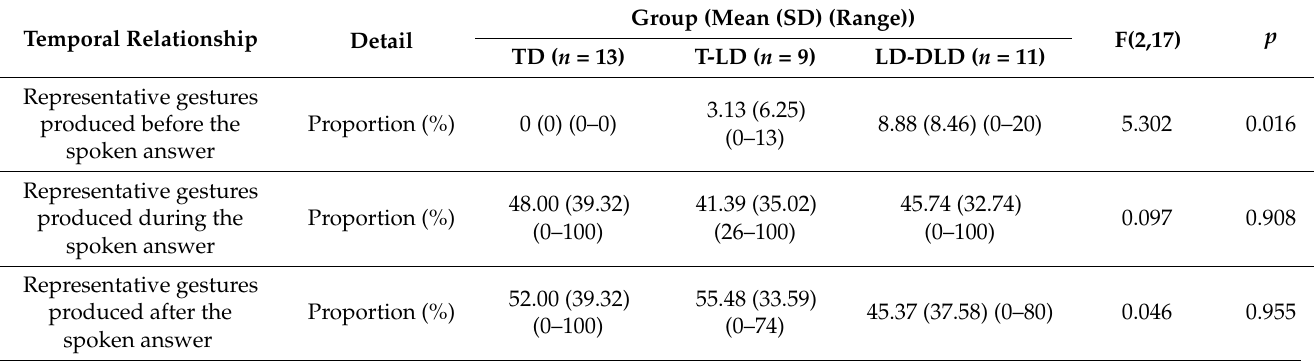
Table 6. Temporal relationships between representative gestures and words in bimodal